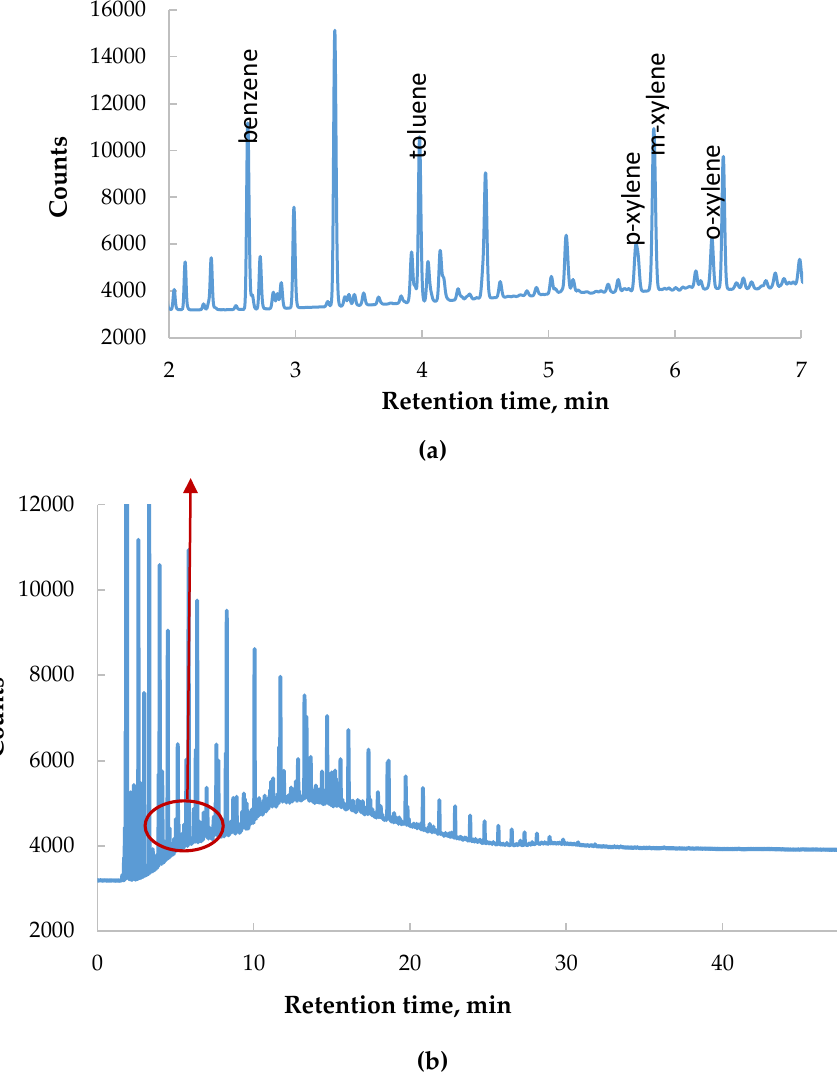
Figure 3. ( a ) Identification of BTX (benzene, toluene, xylenes) components on the whole oil chromatogram; ( b ) whole oil gas chromatogram.